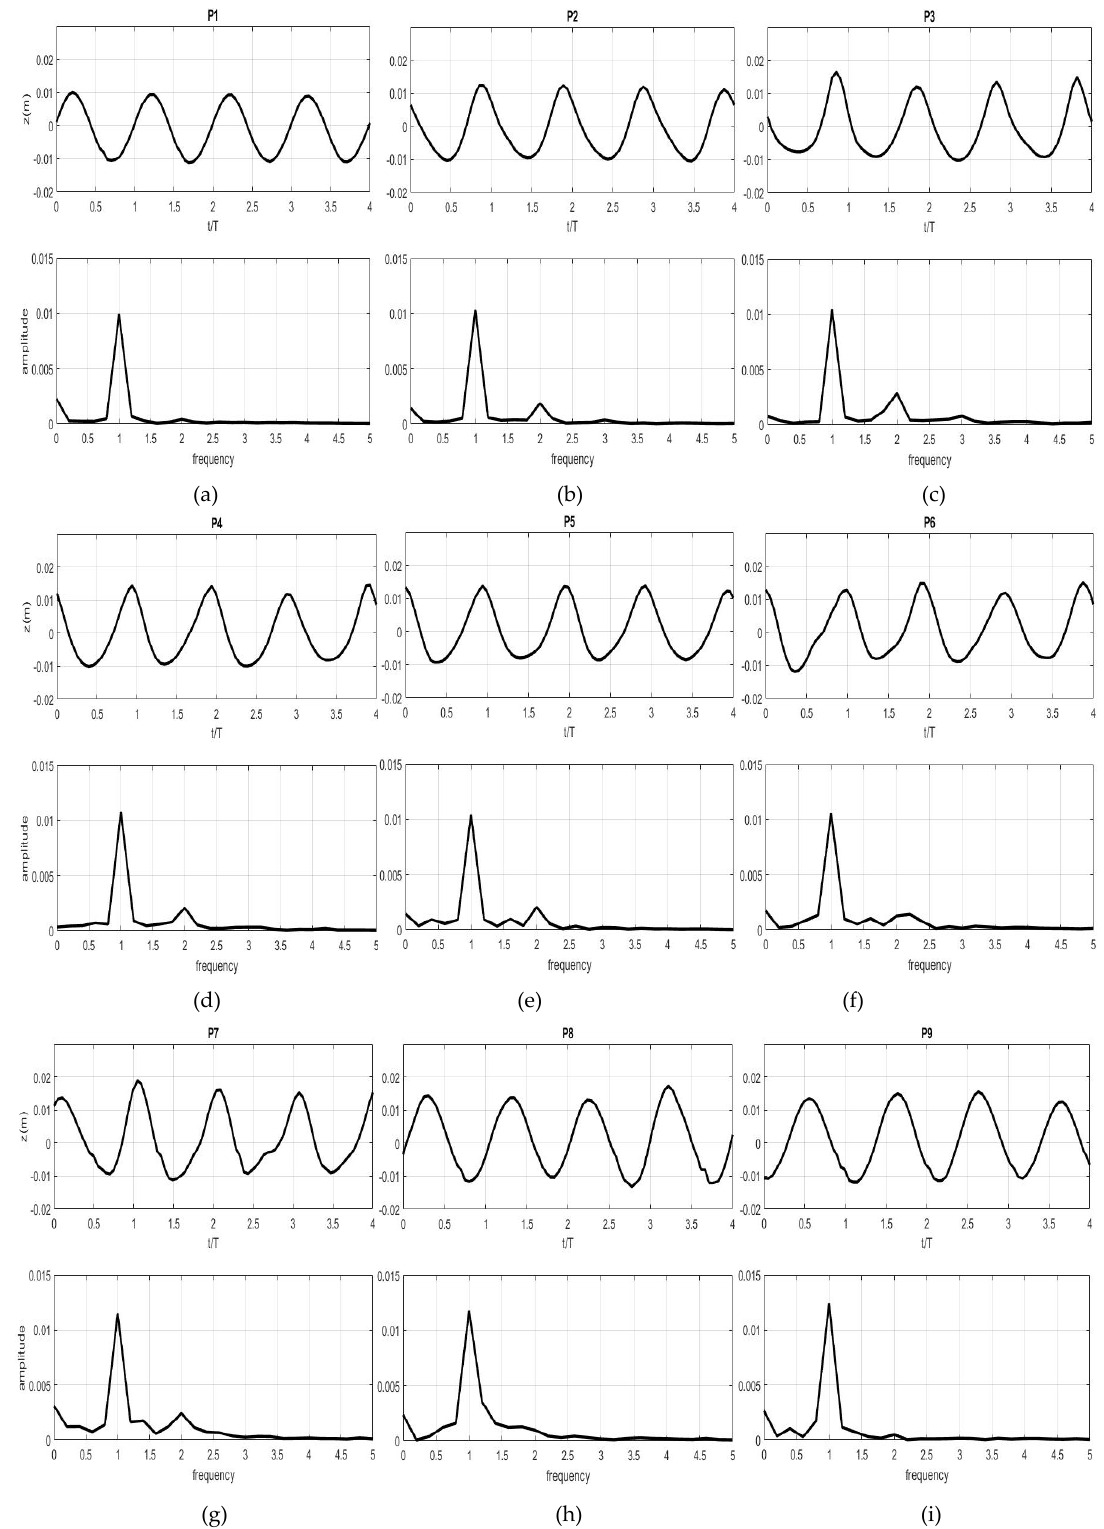
Figure 8. Simulation of surface elevations (upper) and amplitude spectra (lower) at nine positions with the incident wave height H i = 0.02 m and period T = 1.01 s passing over the trapezoidal submerged structure. Explanations of ( a-i ) are given in the caption of figure 7.